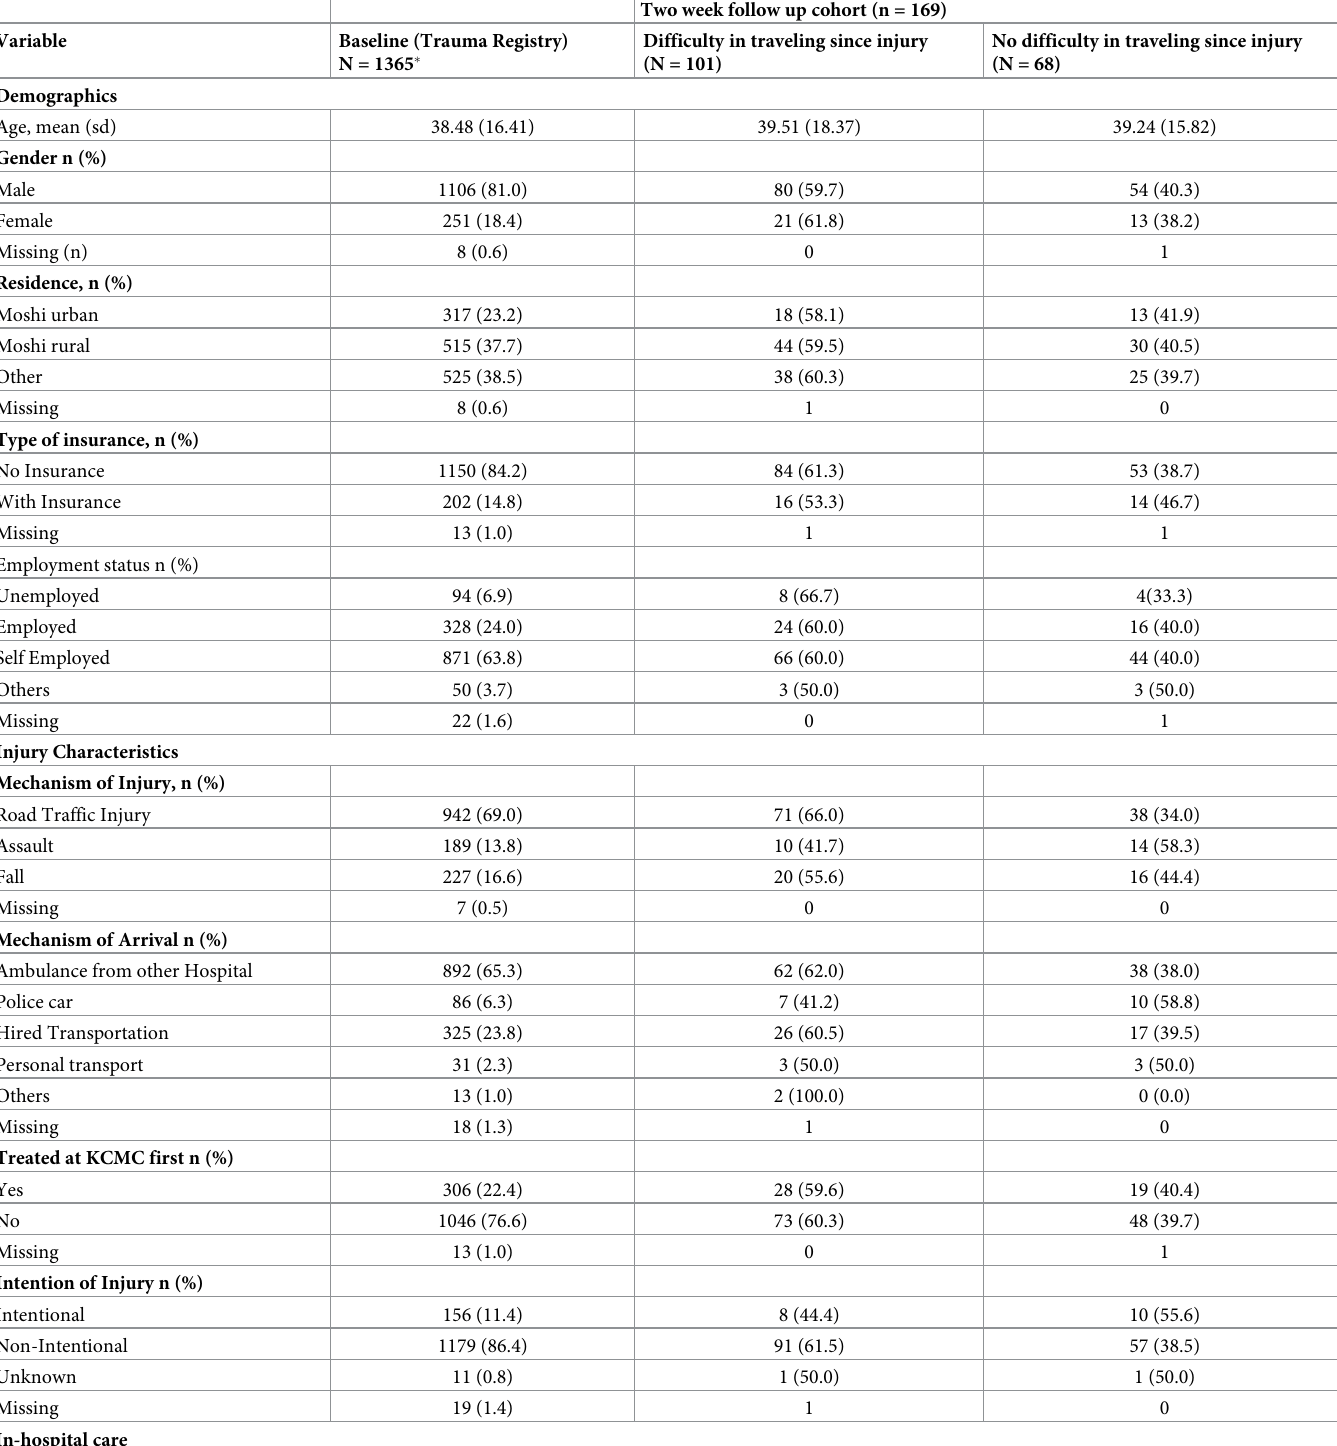
Table 1. Demographics, injury characteristics, clinical/functional variables and transportation/support information for trauma patients during hospital stay and at two week